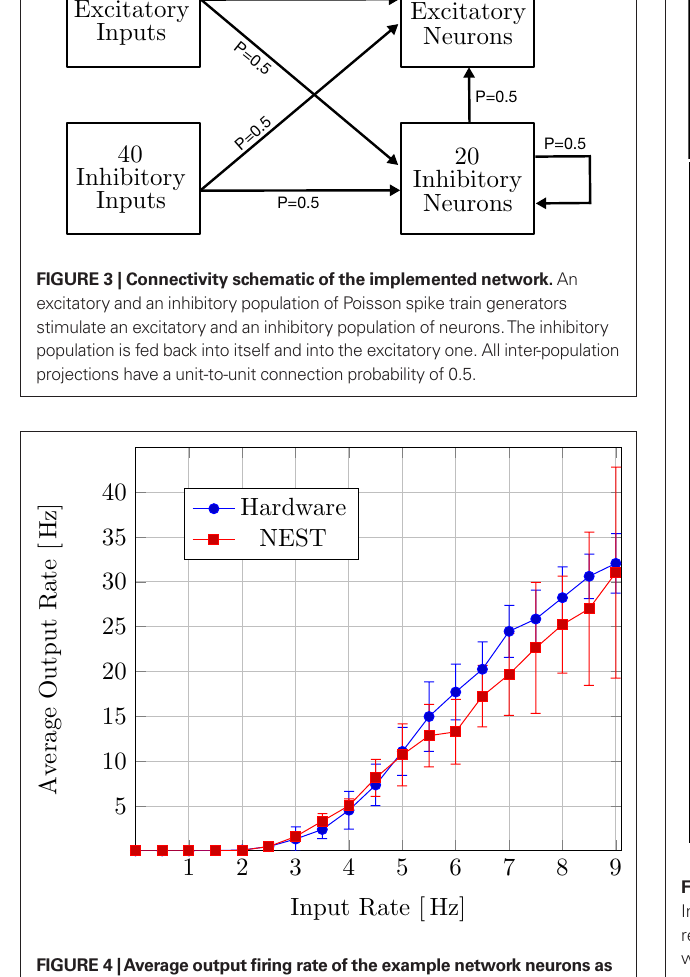
FIGURE 4 | Average output fi ring rate of the example network neurons as a function of input rate. The script shown in Listing 1 has been executed with various stimulation rates on both the hardware system (blue circles) and the software simulator NEST (red squares). Each data point represents the mean over 20 runs, the error bars denote the corresponding standard